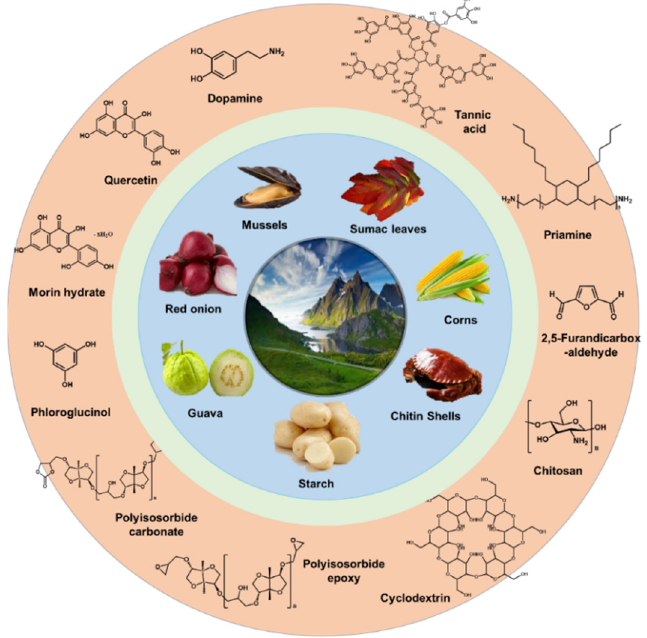
Figure 8. The candidates of the sustainable sources for preparing green selective layer of thin-film composite (TFC) membranes.